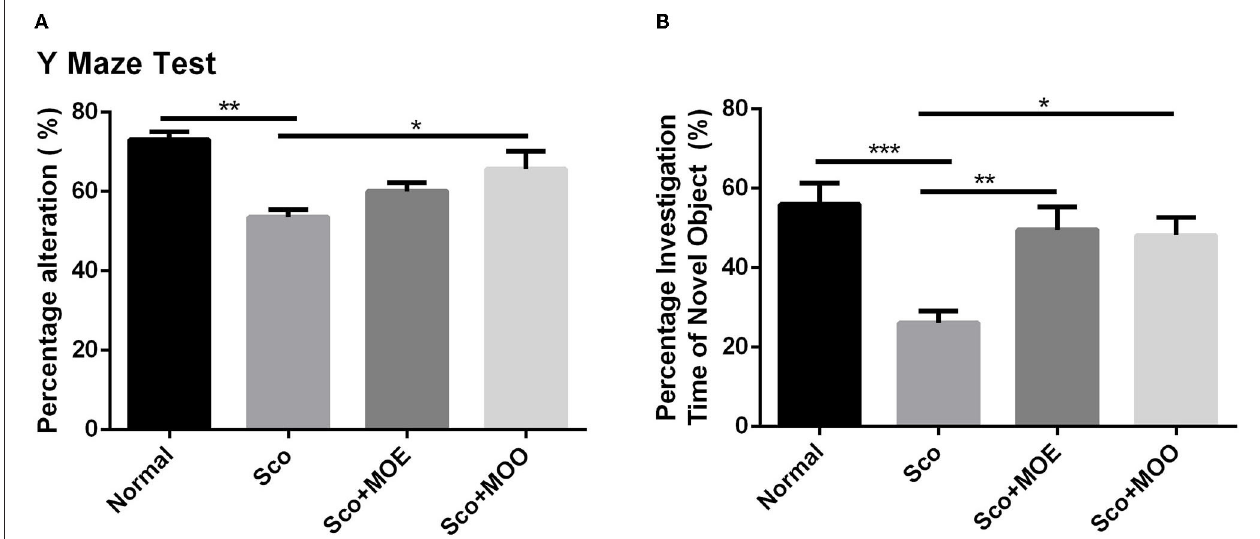
FIGURE 2 | (A) Effects of M. oleifera leaves extract (MOE) and MOO on scopolamine (Sco)-induced memory impairments in Y-maze test by assessed the percentage alteration. Each column represents mean ± SEM of six mice. Data analysis was performed using one way ANOVA, followed by Tukey’s multi comparison test. ** p < 0.01; * p < 0.05. MOE, aqueous leaves exctract of M.oleifera ; MOO, M.oleifera seed oil. (B) Effect of MOE and MOO on Sco-induced memory impairments in novel object recognition (NOR) test by assessed the percentage investigation time to novel object. Each column represent mean ± SEM of six mice. Data analysis was